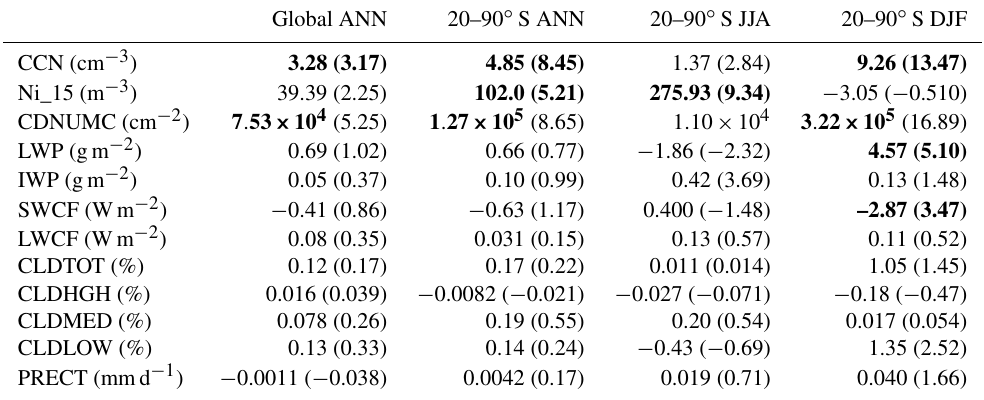
Table 6. Mean changes and relative changes (%) between CTL and B14_D15_M18 experiments. Included in the table are surface CCN concentrations at 0.1% (CCN); ice particle number concentration at − 15 ◦ C thermal level (Ni_15); vertically integrated cloud droplet number concentration (CDNUMC); total grid box cloud liquid water path (LWP); total grid box cloud ice water path (IWP); shortwave and longwave cloud forcings (SWCF, LWCF); total cloud fraction (CLDTOT); high, mid-level, and low-level clouds (CLDHGH, CLDMED, CLDLOW); and total surface precipitation rate (PRECT), with bold font indicating relative changes larger than